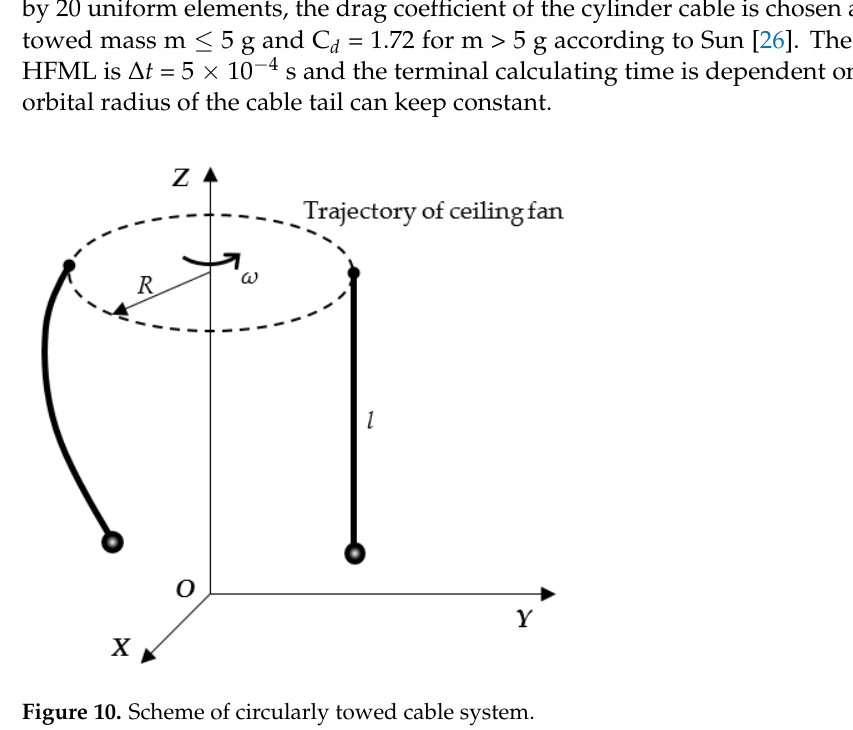
Figure 9. Configuration comparisons for 180 0 U-turn towing process.